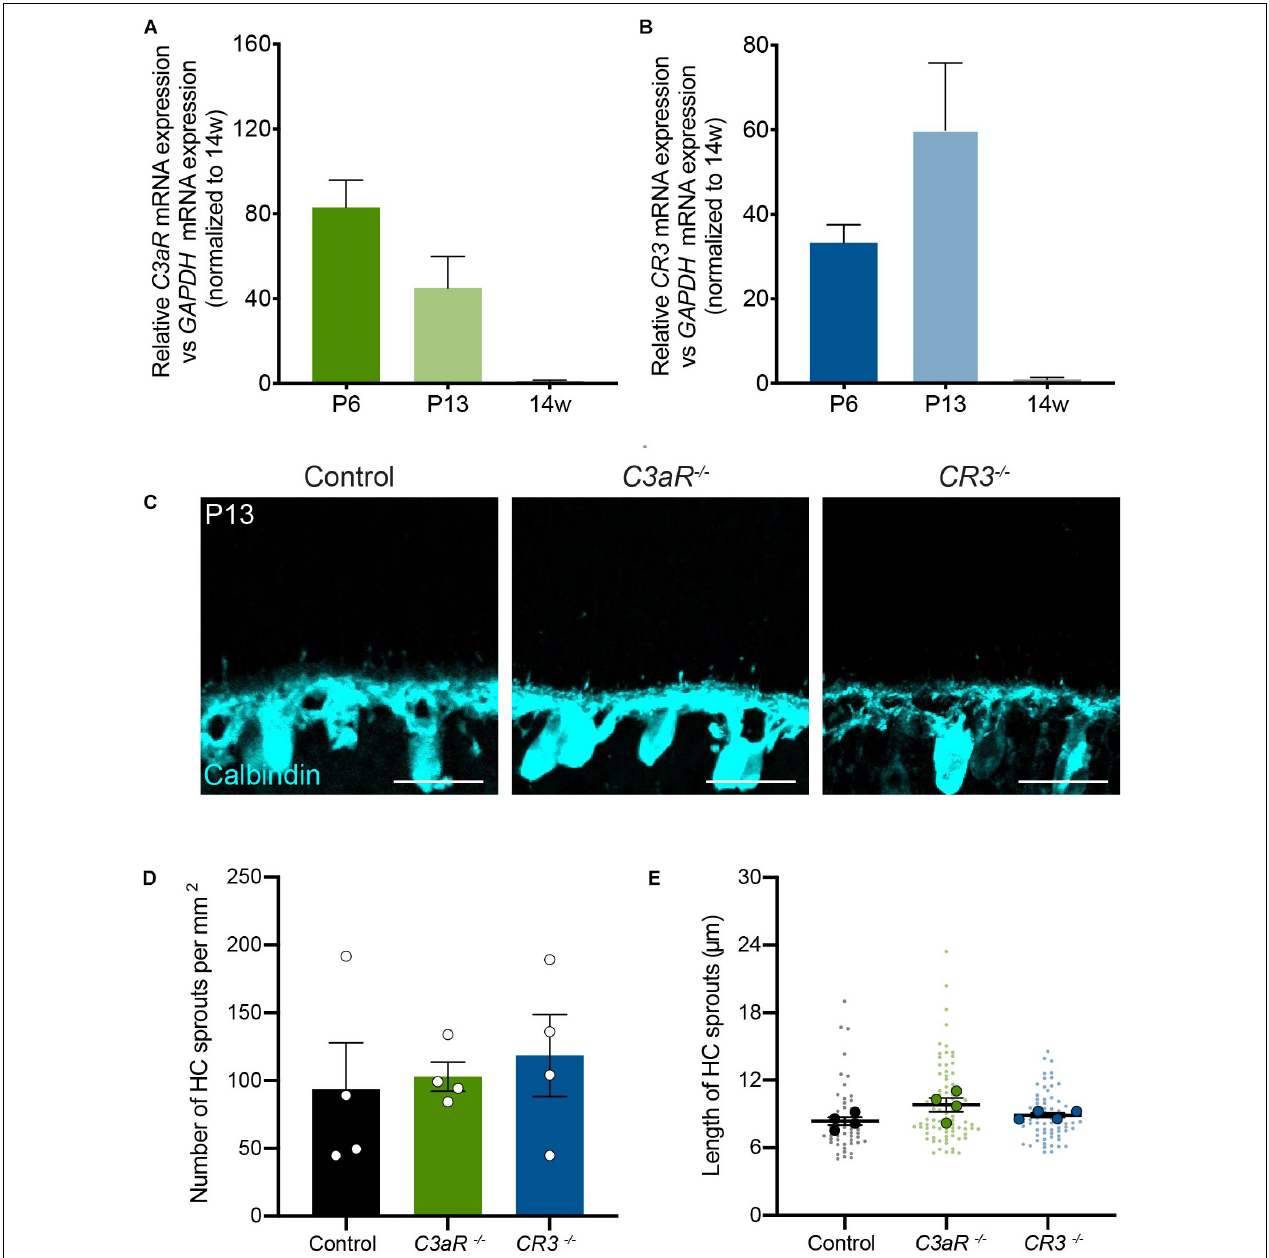
FIGURE 5 | Horizontal cells develop normally with the loss of either C3aR or CR3. (A,B) qRT-PCR for complement proteins C3aR and CR3 at P6, P13, and adult in wild type mice. Values represent the fold mRNA expression level relative to the levels detected in control animals following normalization to GAPDH . N = 3 animals. Representative images of horizontal cells ( C , anti-calbindin, cyan) and quantifications (D,E) of ectopic horizontal cell neurites in control and C3aR − / − or CR3 − / − mice at P13. Horizontal cell neurites in C3aR − / − and CR3 − / − mice remain confined to the OPL, showing no increase in the number (D) or length (E) of ectopic neurites ( n = 52 sprouts from four control mice; n = 84 sprouts from four C3aR − / − mice; n = 67 sprouts from four CR3 − / − mice). Scale bars = 25 µ m. Data are represented as the mean ± SEM (D) or as beeswarm SuperPlots (E) in which individual horizontal cell sprout values are presented together with the mean from each animal ± the